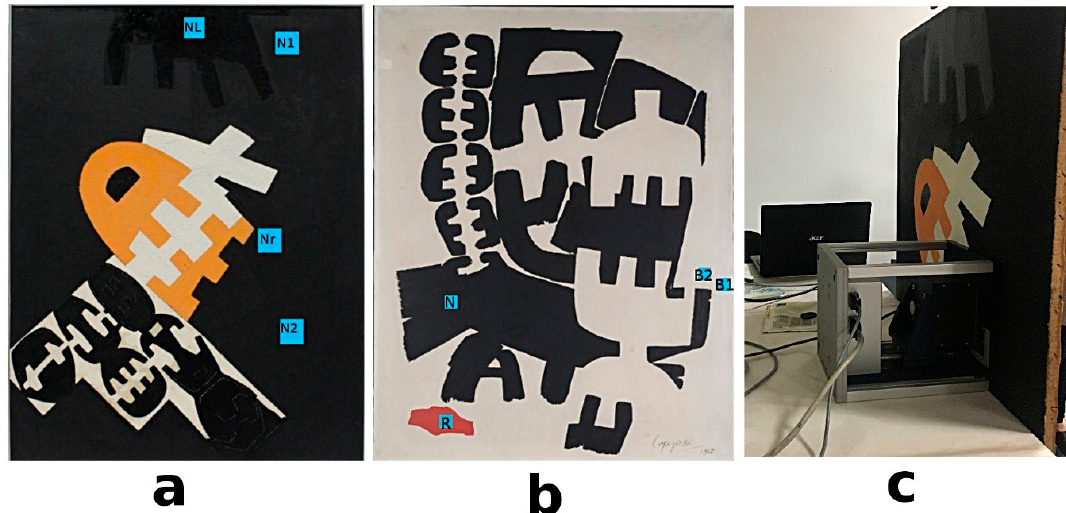
Figure 2. ( a ) “Surface 538” painting; ( b ) “Surface 553” painting; ( c ) portable NMR sensor while scanning the painting at the National Gallery of Modern Art (GNAM) in Rome. Nr indicates a repainted black area; NL indicates a shiny black area; N1 and N2 indicate two black areas with a similar appearance. N indicates a black area; R indicates a red area; B1 and B2 indicate two white areas with a similar appearance.